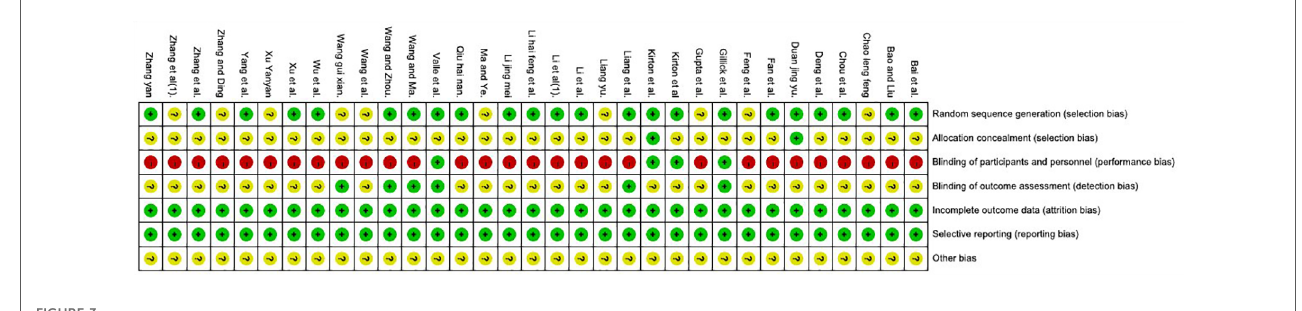
(D) standing, and (E) walking/running/jumping. The analysis was performed according to the fi ve domains and total score.